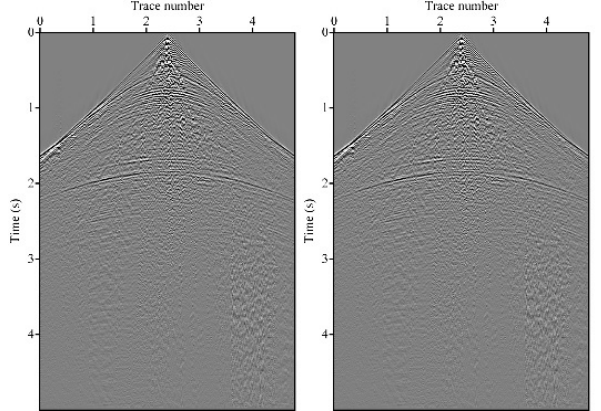
Figure 14. Two shot gathers.